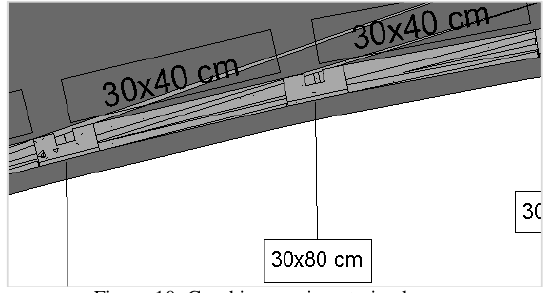
Figure 10: Graphic error in entering beams.